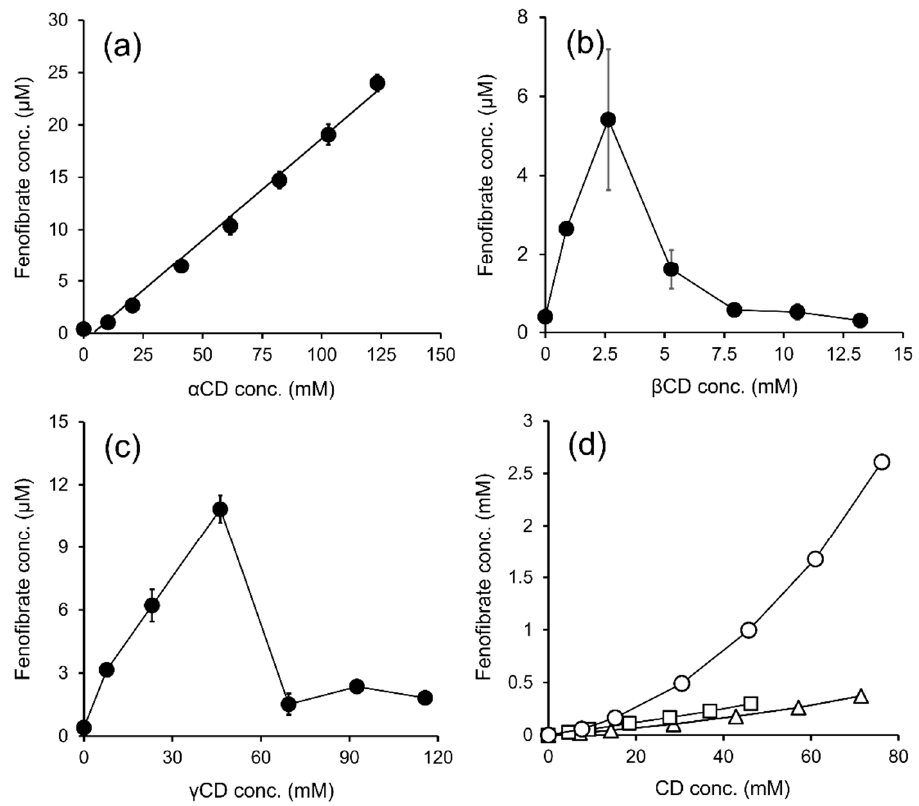
Figure 1. The phase-solubility profiles of fenofibrate in different aqueous CD solutions, namely α CD ( a ), β CD ( b ), γ CD ( c ), and β CD derivatives ( d ), which include HP β CD ( △ ), SBE β CD ( ◻ ), and RM β CD ( ◯ ).